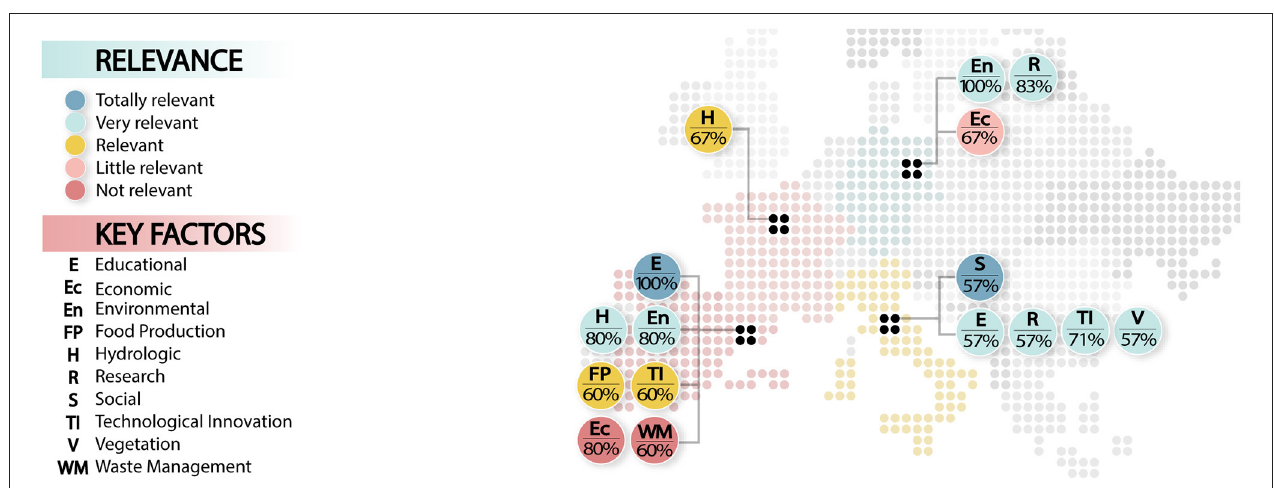
FIGURE 4 | Perceived relevance of key factors in four European cities for integrating